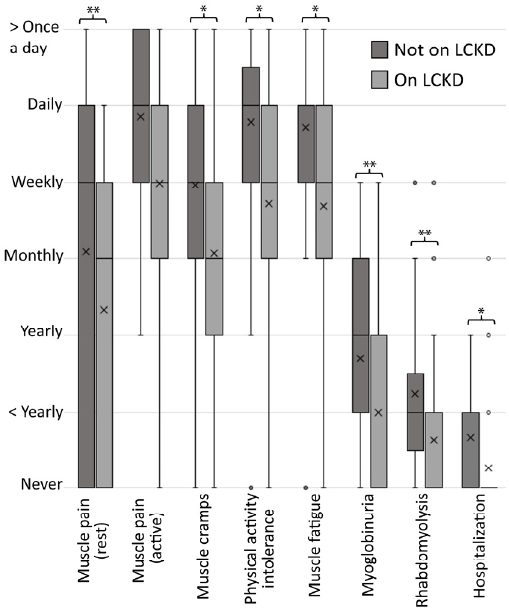
Figure 4. Frequency of McArdle disease-related symptoms while on and not on a low carbohydrate ketogenic diet (LCDK). The boxes illustrate the lower quartiles (Q1), medians (Q2), and upper quar- tiles (Q3). The cross illustrates the means. The whiskers illustrate the minimum and maximum, and the circles illustrate outliers. Statistically significant differences are illustrated with *: p < 0.05 and **: p < 0.001. Based on n = 57 responses.